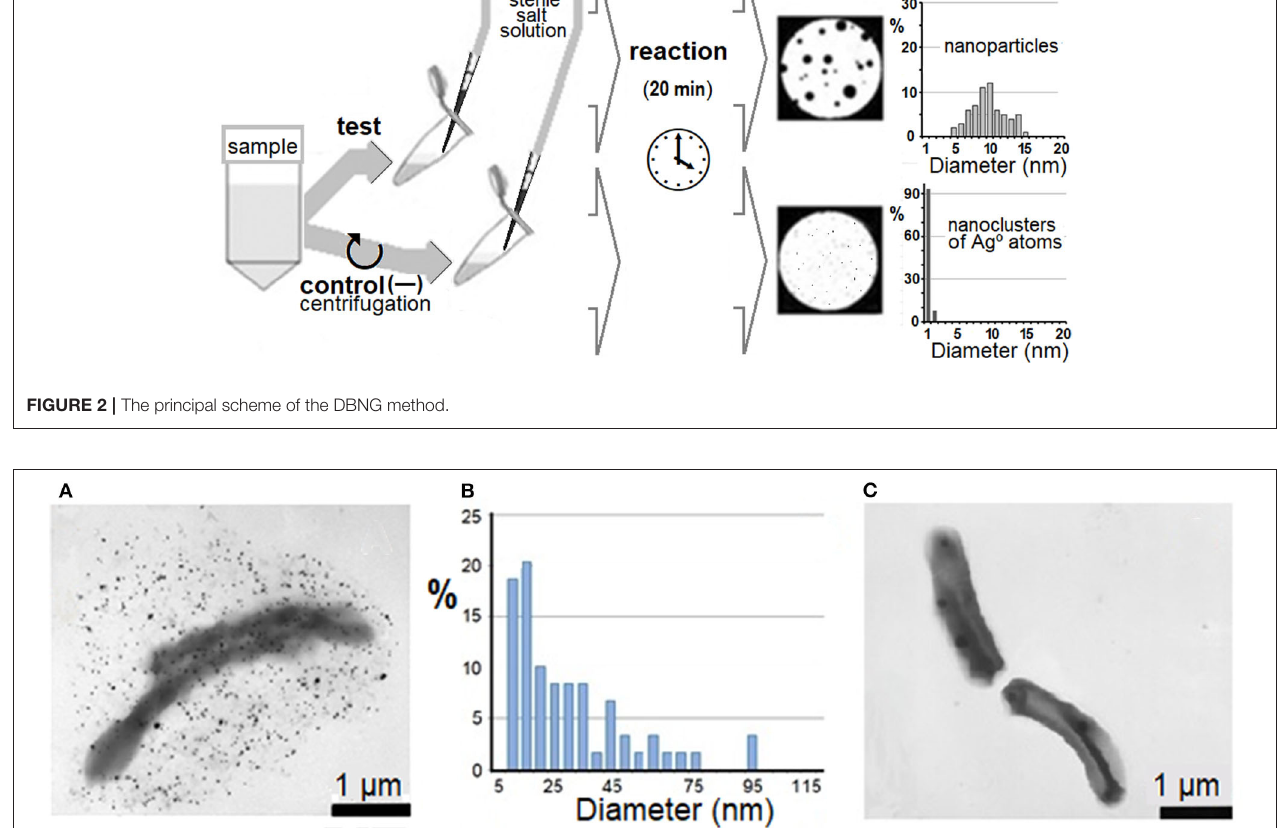
to reduce Ag + cations fast and generate nanoparticles under non-optimal temperature conditions (at + 24 ◦